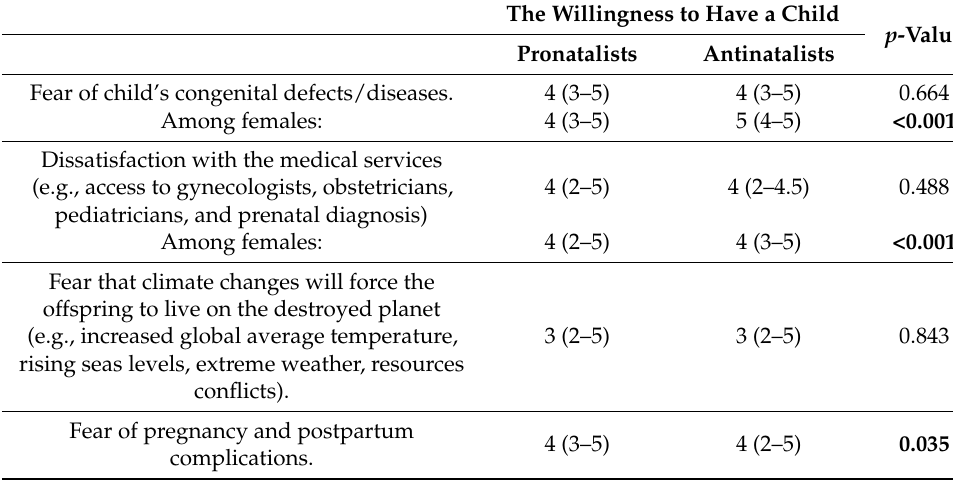
Table 3. Parameters discouraging from having a child. 1—does not discourage at all, 2—rather does not discourage, 3—has no opinion, 4—rather discourages, 5—definitely discourages. Data